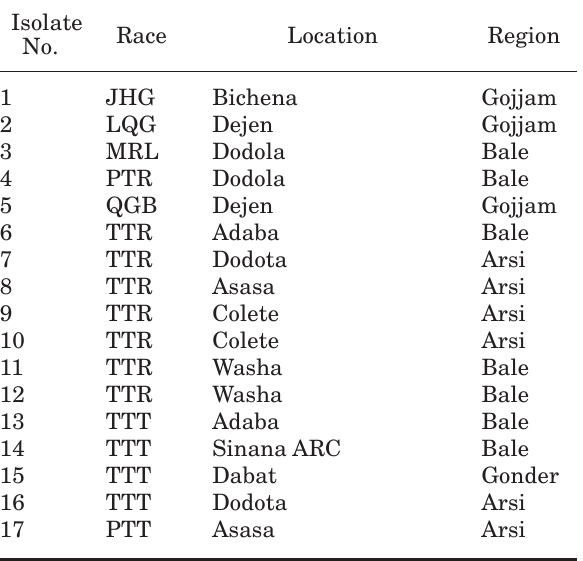
Table 4. Races of Puccinia graminis f. sp. tritici in the Shewa, Arsi and Bale regions of Ethiopia in 2004. Isolate No.